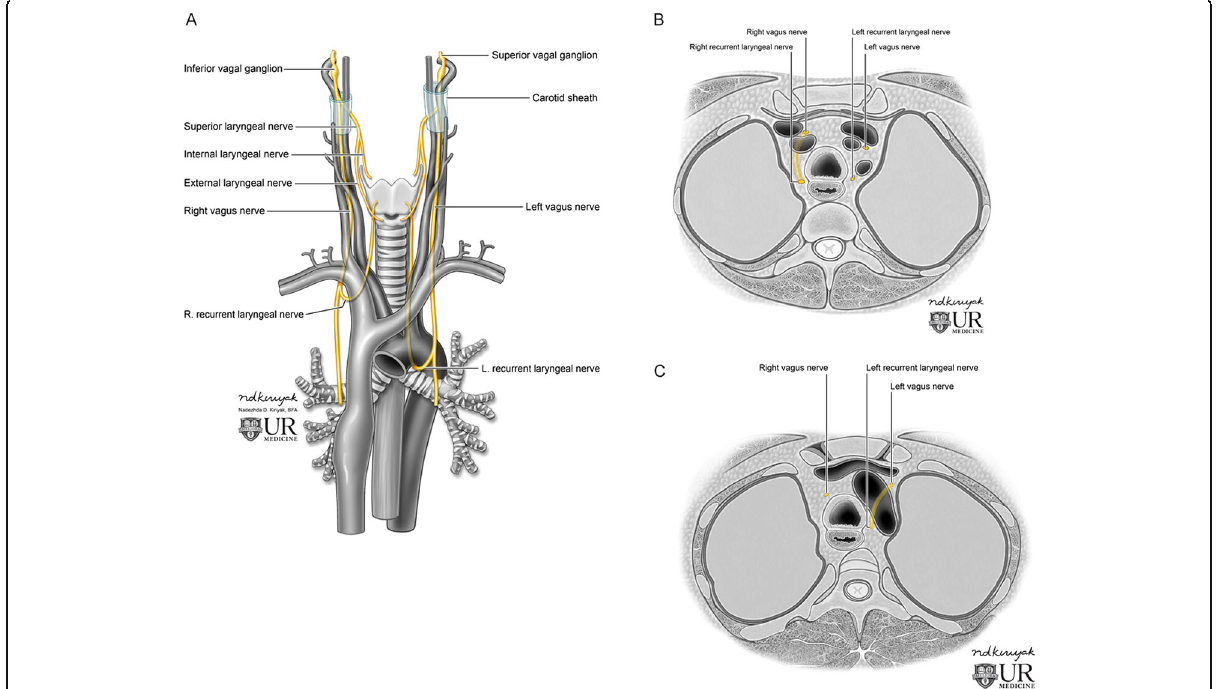
Fig. 3 Representative coronal ( a ) and axial ( b , c ) illustrations demonstrating the normal course of the bilateral vagus and recurrent laryngeal nerves. The right recurrent laryngeal nerve loops posteromedially under the right subclavian artery ( a , b ), and the left recurrent laryngeal nerve loops posteromedially beneath the aortic arch ( a , c )